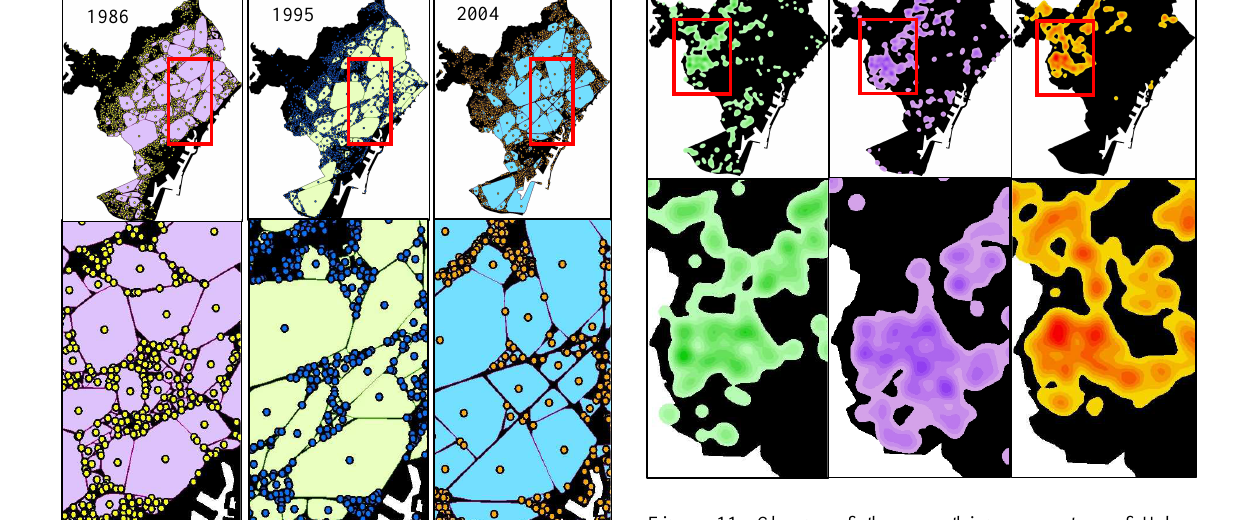
Figure 11: Change of the smoothing parameters of Urban Density. Kernel density with window 10 by 10 meters and 300m search radius already applied for above